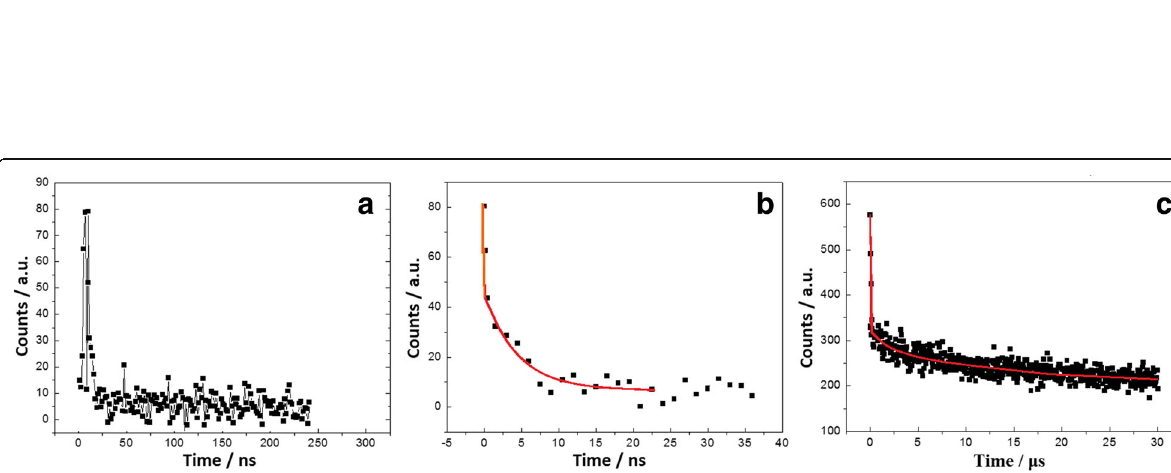
Fig. 6 a PL decay spectra near 400 nm with the faster photons. b PL decay spectra near 560 nm with the faster photons (ns) on smaller Si NCs. c PL decay spectra near 700 nm with the faster photons (ns) related to the impurity state emission and the slower photons ( μ s) on larger Si NCs